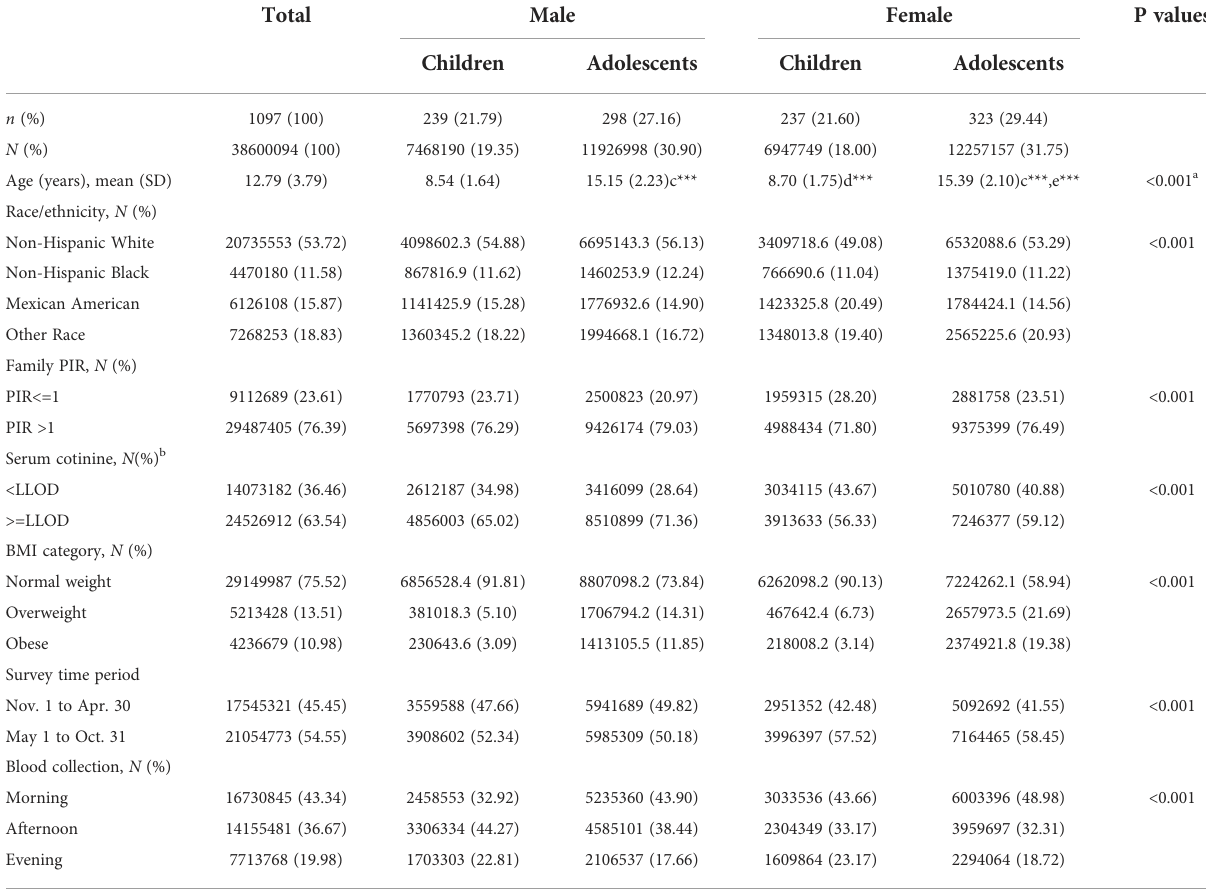
TABLE 1 Demographic characteristics in different